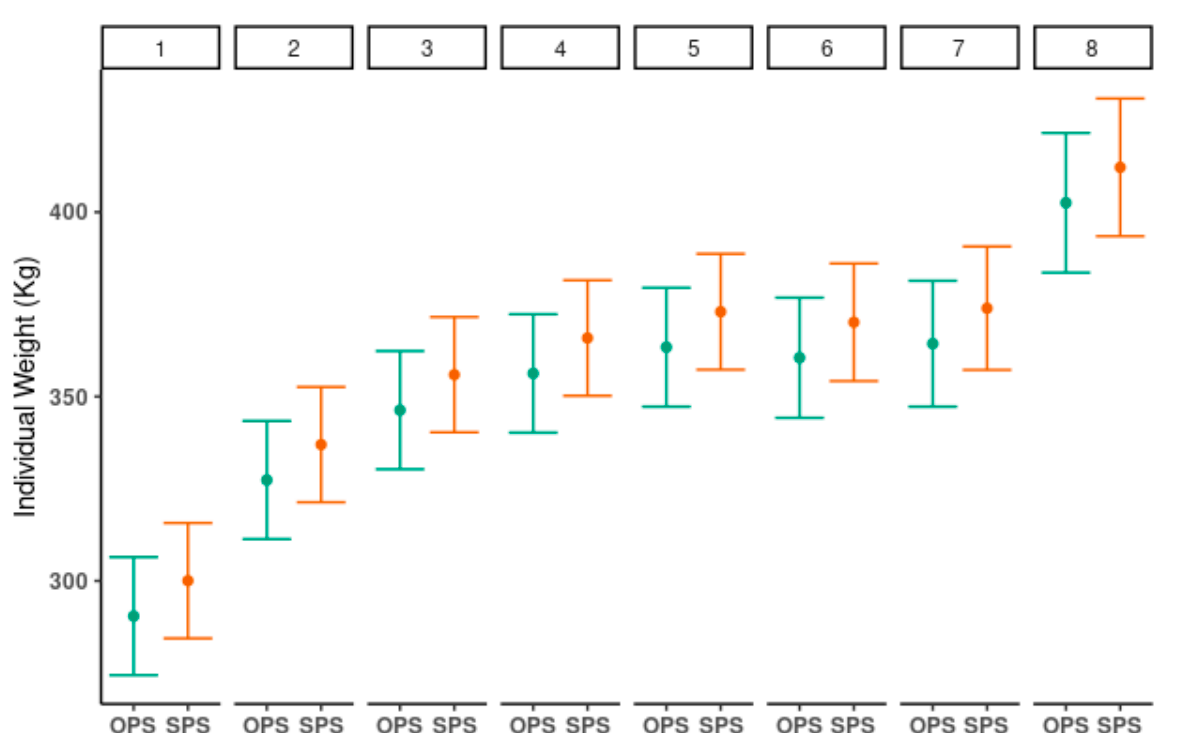
Figure 5. Mean weights and 95% confidence intervals of individual weights (kg) by herd and system across the eight visits. OPS: Open pastures systems; SPS: Silvopastoral systems.